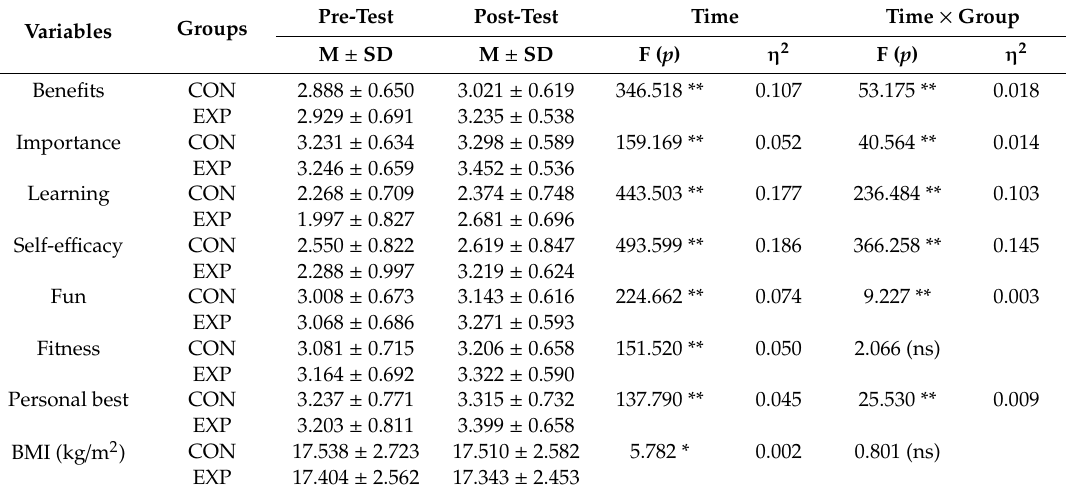
Table 3. Descriptive statistics of the control and experimental groups and results of the repeated measures